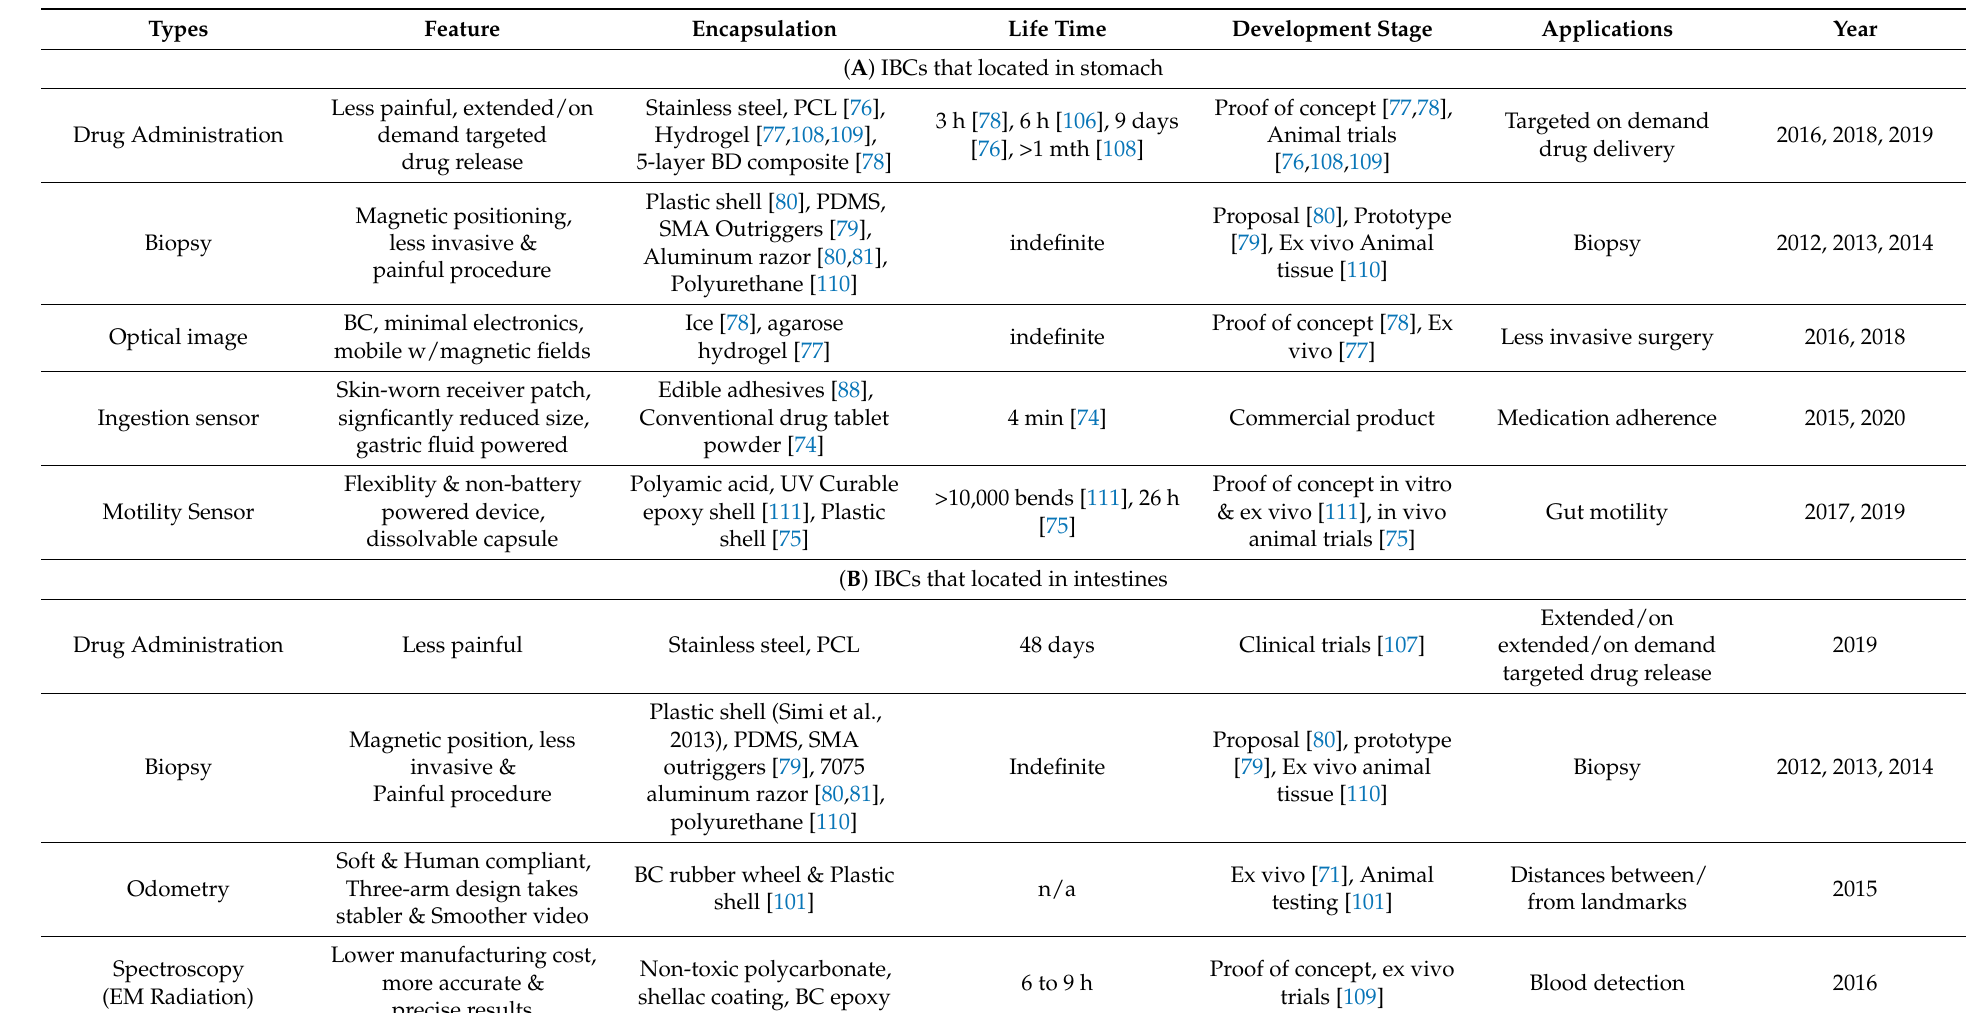
Table 3. Summary of sensing and operational devices of